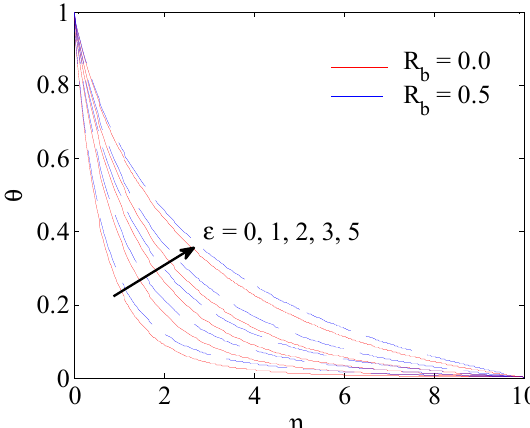
Figure 8. Fluctuations of θ due to the factor W (cid:2915) .